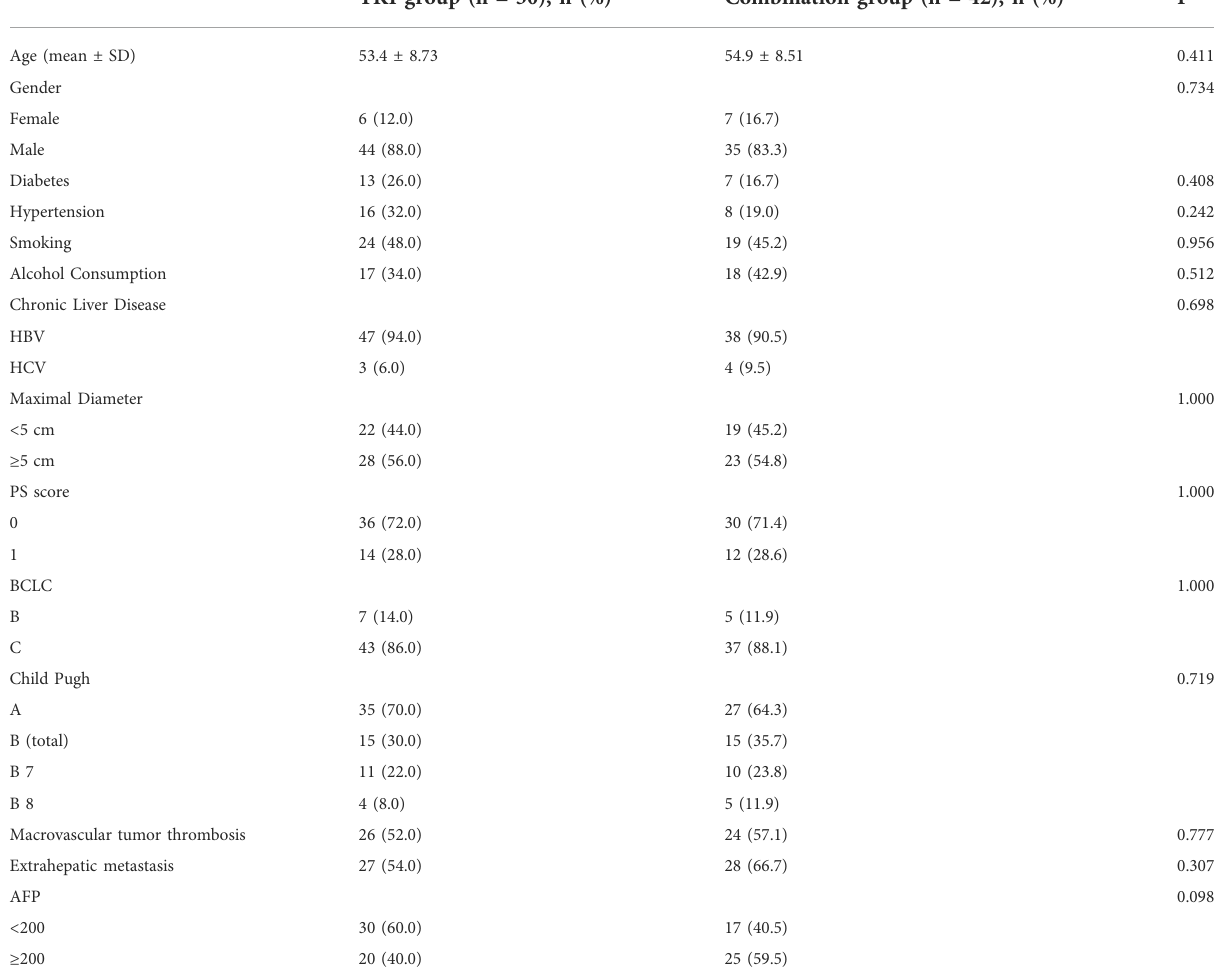
TABLE 1 Baseline patient characteristics.